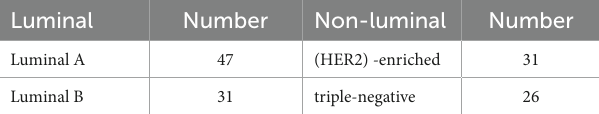
TABLE 1 Histologically confirmed tumor distribution in the whole